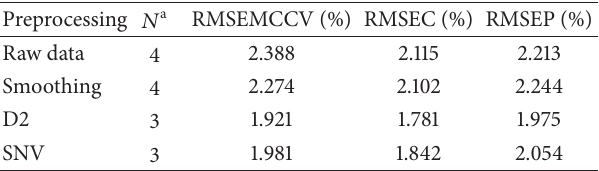
Table 1: Quantitative analysis of wheat flour in oat flour by